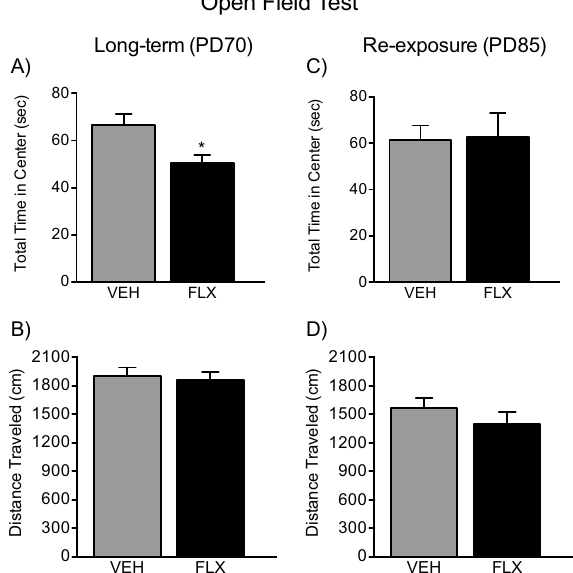
Figure 2. Long-term effects of juvenile fluoxetine (FLX) treatment, and its re-exposure in adulthood, on the open field test. ( A ) FLX pretreatment during adolescence (PD35-49) resulted in a decrease in the time spent in the center area of the open field arena at PD70 (Long-Term). ( B ) FLX pretreatment did not influence total distance traveled during the 5-min session of the open field test. ( C ) Re-exposure to FLX in adulthood (PD70- 84) ameliorated the long-lasting anxiety-like effect of adolescent FLX pre-exposure, as no differences in total time spent in the center between the groups were observed. ( D ) At PD85, no differences in distance traveled were apparent between the experimental groups. Data are presented as mean ± SEM. * p <